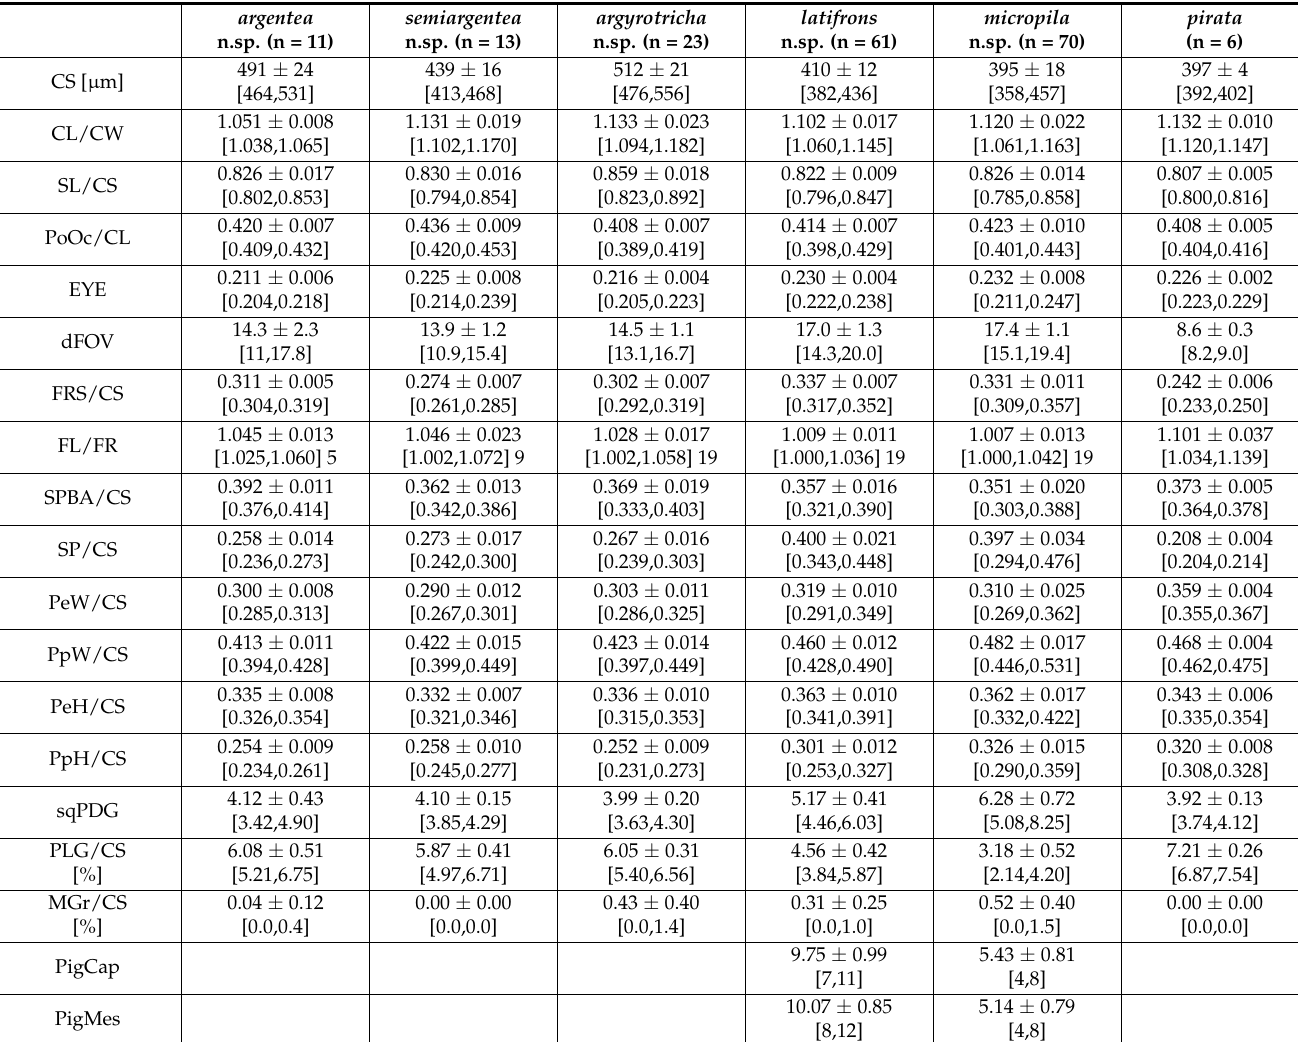
Table 2. Measurements of workers of the Cardiocondyla argentea group. Explanation of data arrange- ment as in Table